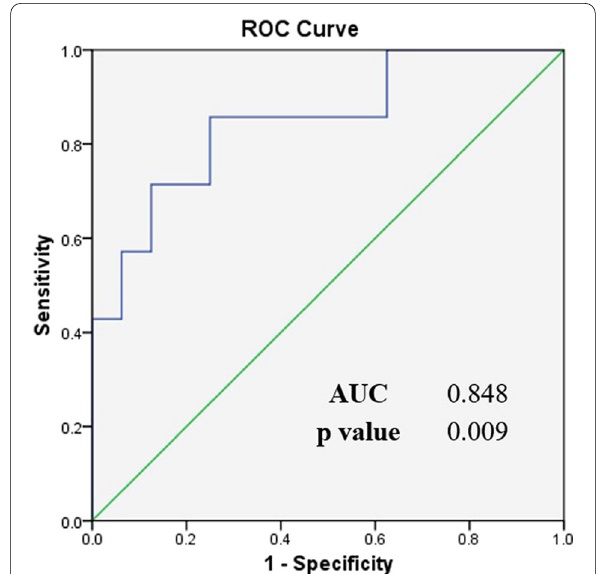
Fig. 4 ROC curve analysis of ADC value in differentiating non-vulnerable plaque from vulnerable